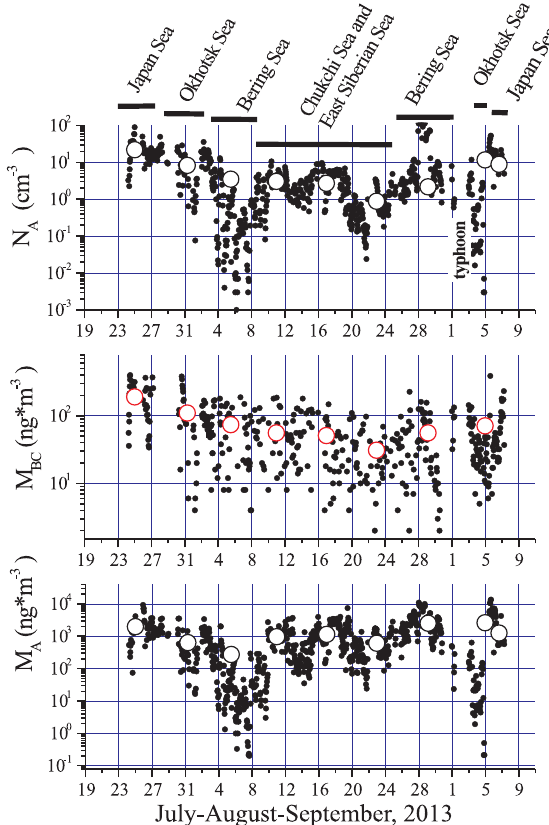
Figure 6. Temporal behavior of the parameters N A , M A , and M BC on the route of RV Professor Khljustin (circles indicate the average values of the parameters in water basins of separate seas).